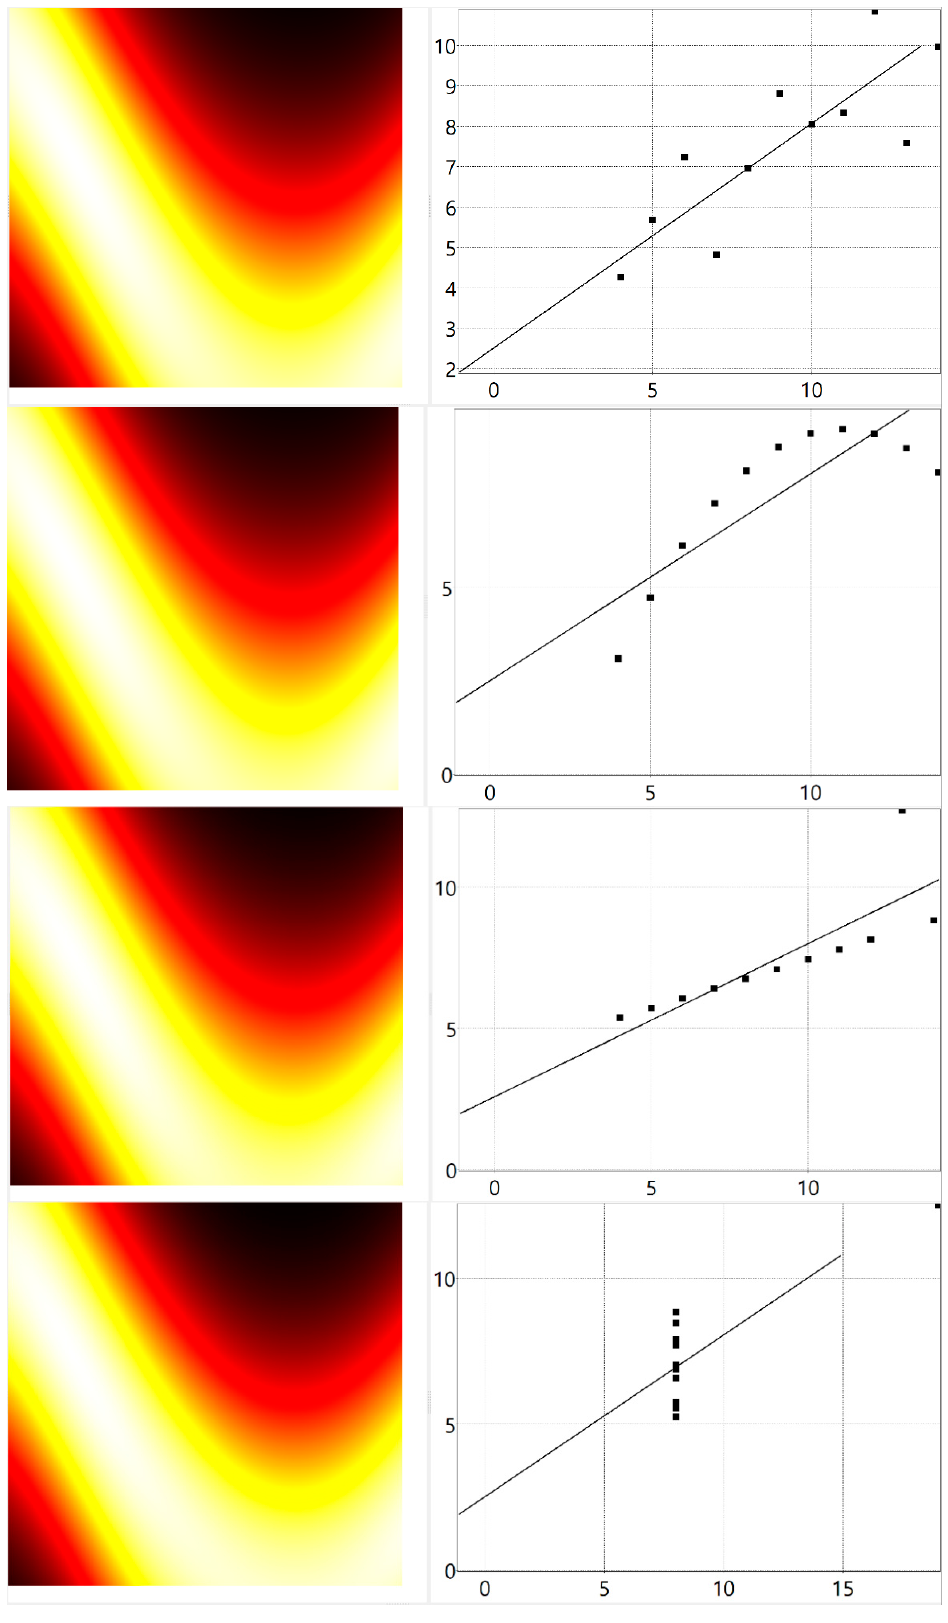
Figure 3. Results of the analysis of the data presented in the Anscombe quartet, with an increase in the scale of the probability distribution function ( σ = 10).